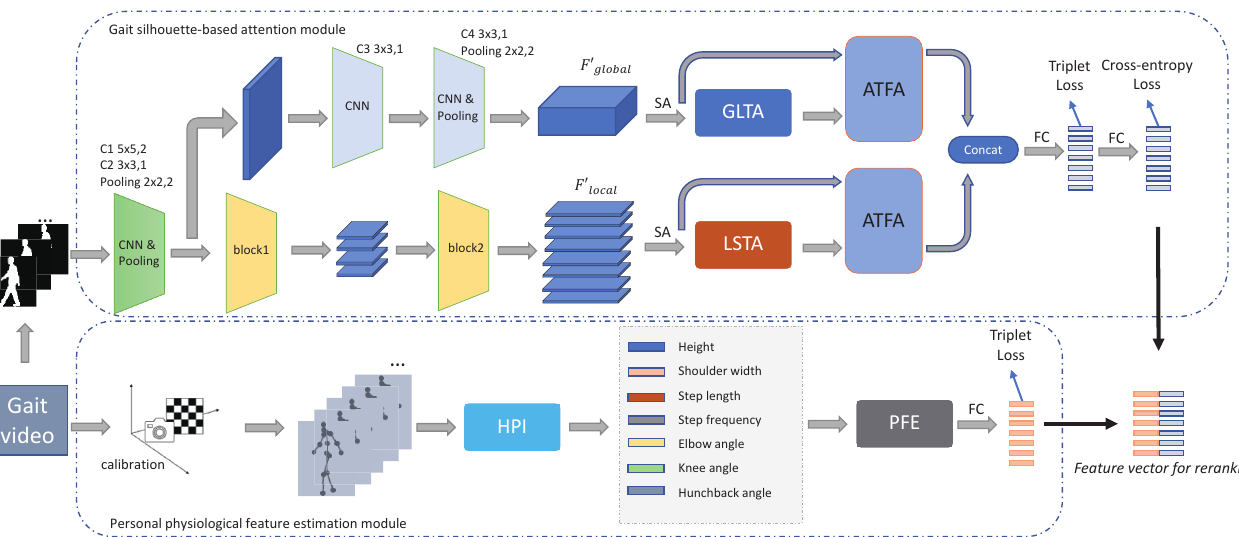
Figure 1. The overviewof this work, which is mainly composed of two parts: the gait-silhouette- based global (local) long (short)-term attention module, and the personal physiological feature estimation